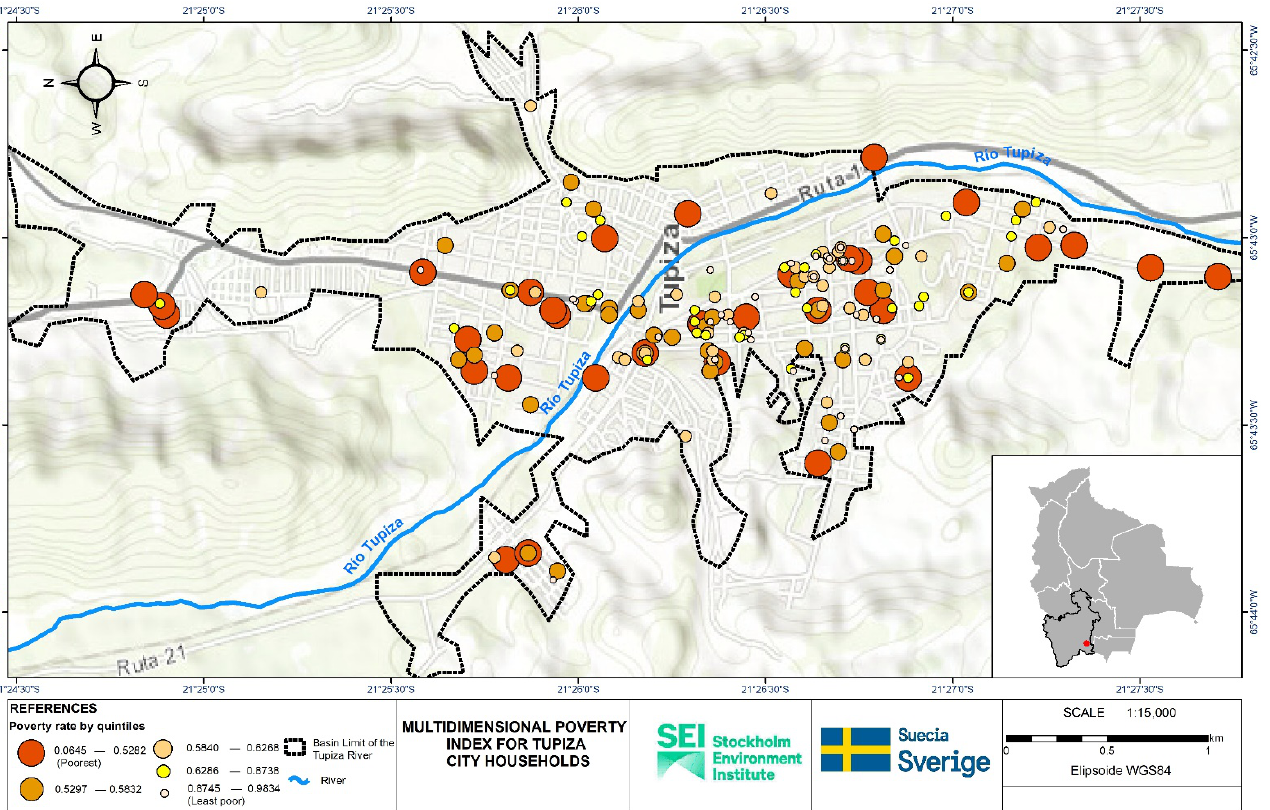
Figure 3. Multidimensional Poverty Index for households in the city of Tupiza.